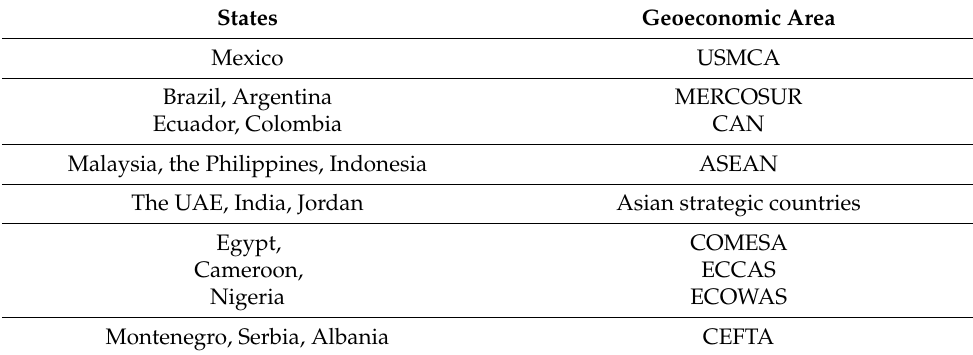
Table 1. List of the states examined in this review and their corresponding geoeconomic